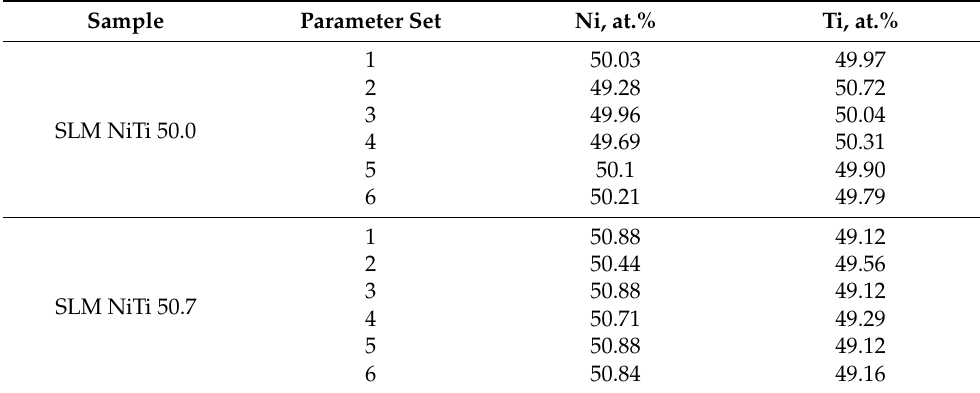
Table 6. The results of studying the chemical composition of samples of the alloy NiTi 50 and NiTi 50.7, obtained by the SLM method in different parameter